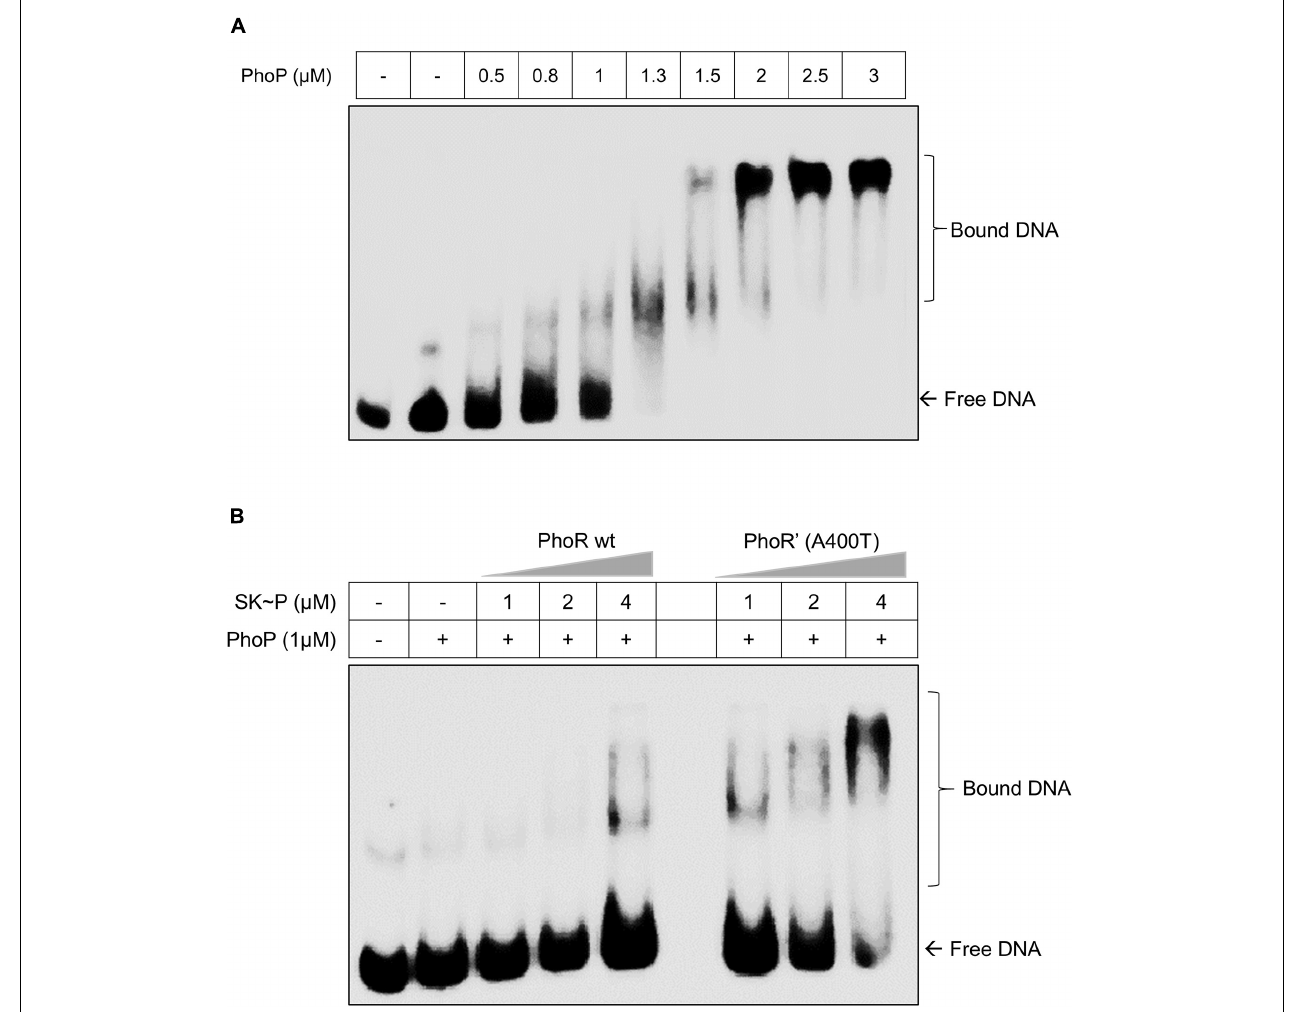
FIGURE 3 | Effect of the PhoR single-nucleotide polymorphism (SNP) on the DNA-binding activity of response regulator (RR) PhoP. (A) Titration of RR PhoP protein to determine a concentration that shows low binding of unphosphorylated PhoP to the promoter region of the aprA gene. The DNA fragment corresponding to the aprA promoter was incubated with an increasing concentration of PhoP protein (as indicated) and tested by electrophoretic mobility shift assay (EMSA). The RR RegX3 was used as a negative control for non-specific binding (lane 2 marked –ve). (B) A comparative analysis of PhoP ∼ P (1 µ M) binding to aprA promoter DNA as a function of phosphorylation mediated by the wild-type [PhoR wt, left] or mutant [PhoR’ (A400T), right] sensor kinase (SK) proteins at different concentrations. For all experiments, n = 3, where n represents the number of biological